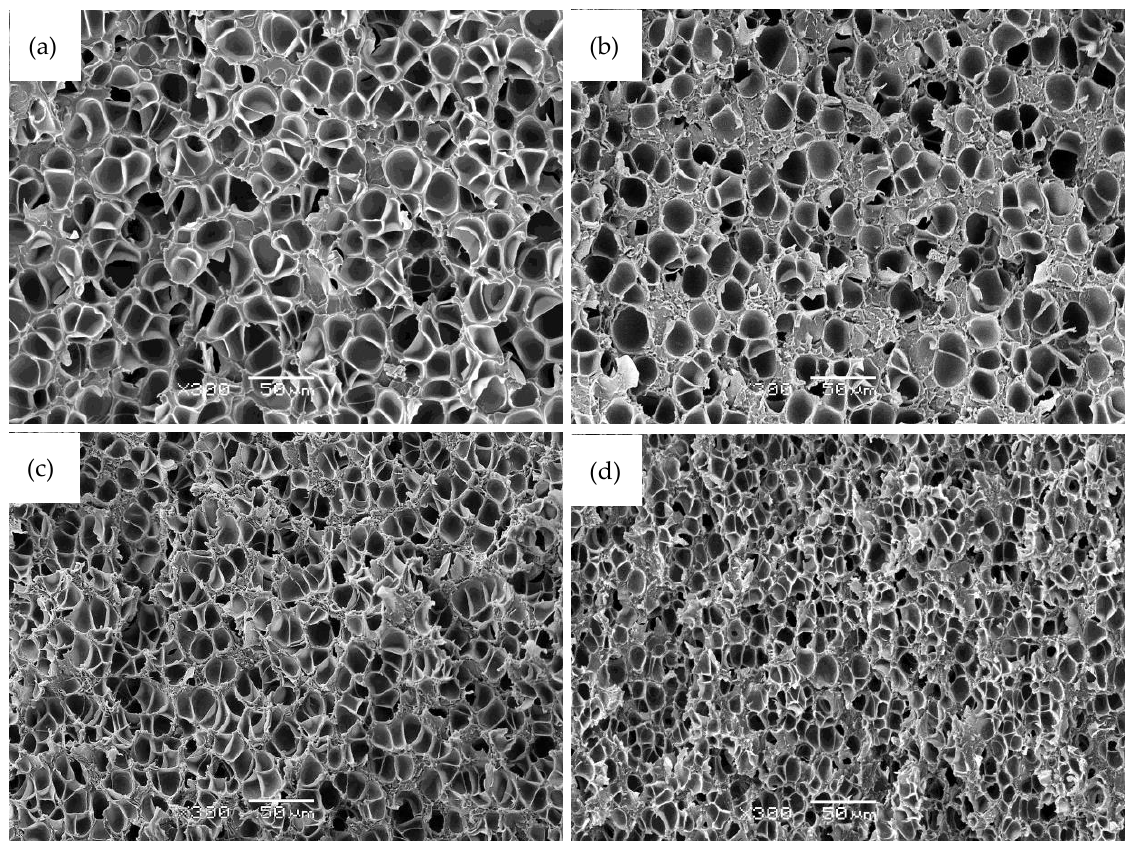
Figure 3. SEM micrographs at ×300 magnification illustrating the microcellular structure of ( a ) pure PEI; ( b ) 0.4 GnP; ( c ) 1.0 GnP; and ( d ) 2.0 GnP foams.